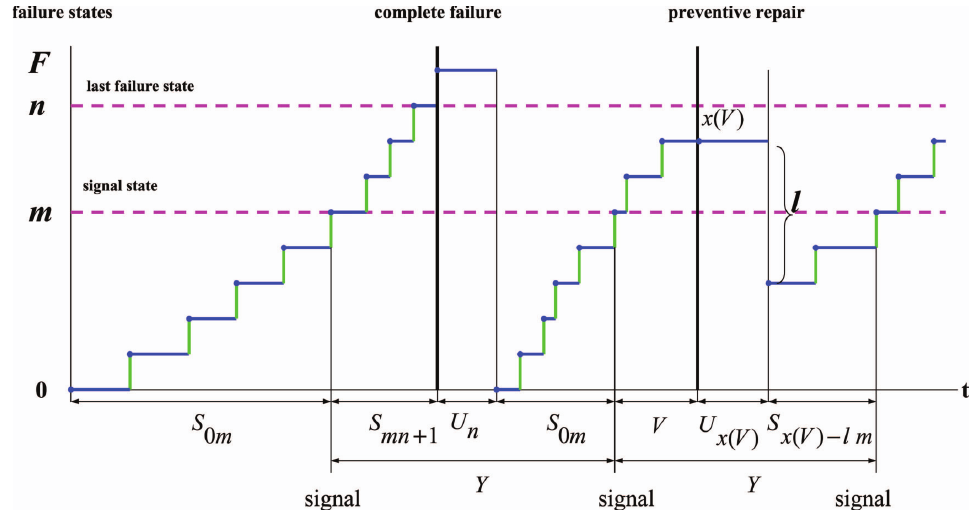
Figure 7. Realization of a degrading process under threshold policy ( m , n ) with l = n − m